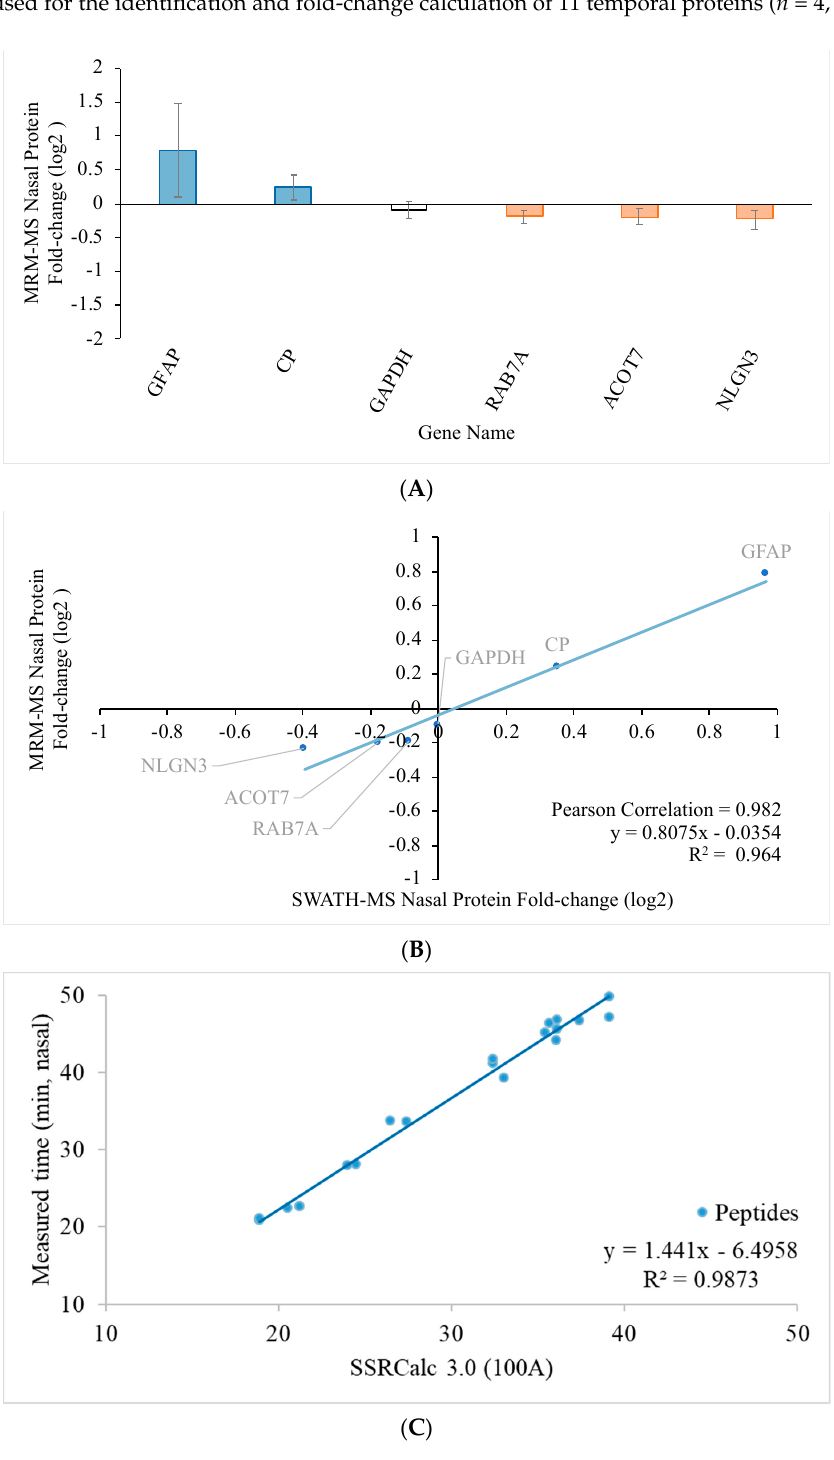
Figure 5. Relationship between protein quantification using targeted SWATH-MS and MRM-MS approaches in the nasal retinal quadrant two weeks after pONT. ( A ) Significantly differentiated retinal proteome in the nasal quadrant after pONT compared to control. The bar chart shows the protein fold change with standard deviation ( n = 4, p < 0.05, 1% FDR). ( B ) The retinal proteome fold- change correlation in the nasal quadrant 2 weeks after pONT treatment measured by independent MRM-MS and SWATH-MS experiments with high regression (R 2 = 0.964) and Pearson correlation (R 2 = 0.982) on differentially expressed proteome. GAPDH was induced as a reference. ( C ) Retention